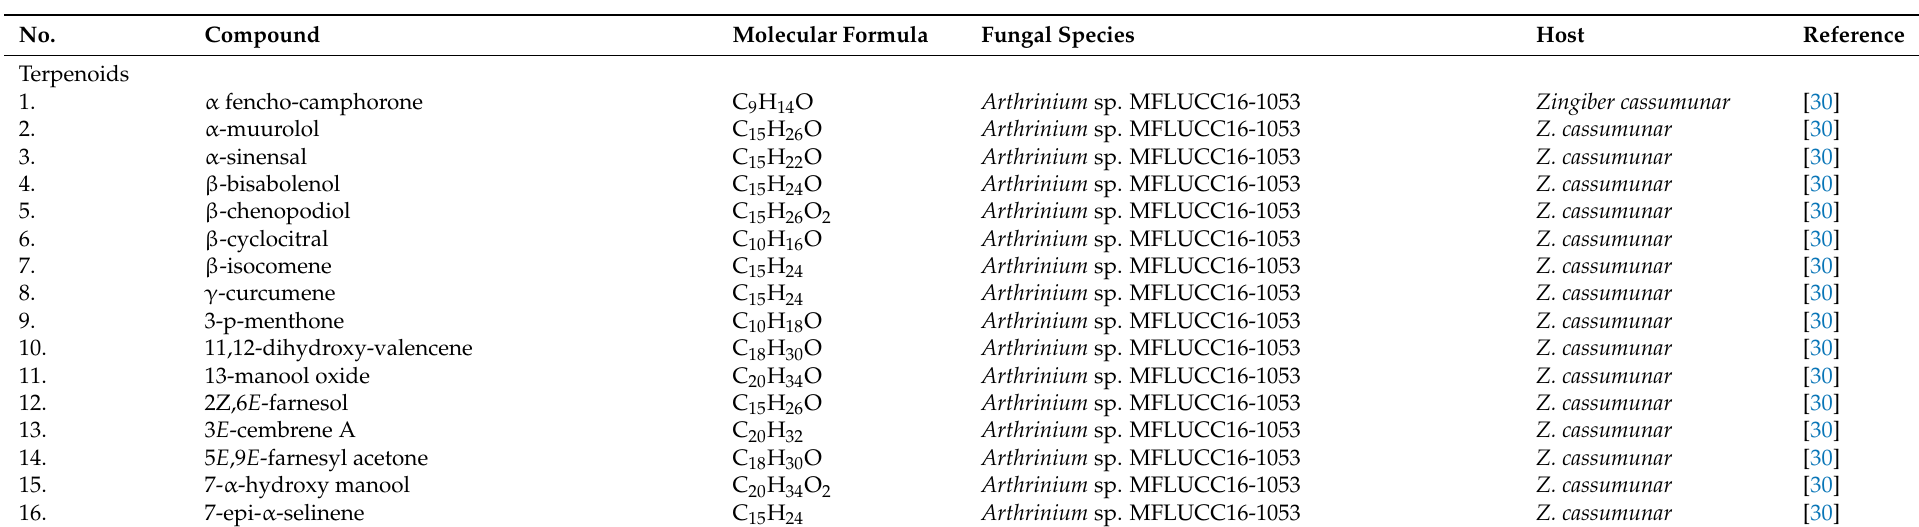
Table 2. Volatile constituents from Zingiberaceae